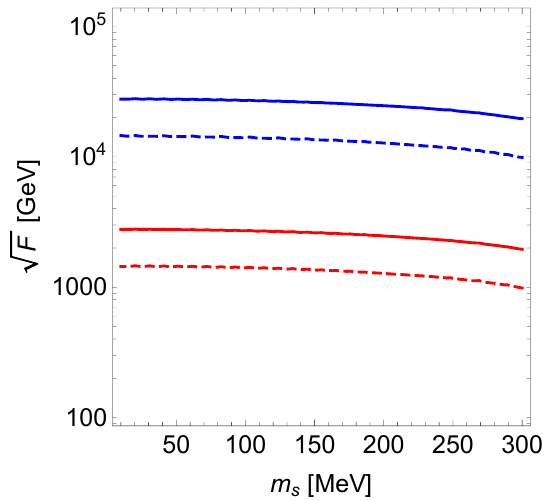
Figure 1 . Contours for branching ratios of processes K L ! (cid:25) 0 s and K + ! (cid:25) + s . The solid colored lines indicate the contours for BR( K L ! (cid:25) 0 s ). Dotted lines of corresponding colors show where BR( K + ! (cid:25) + s ) achieves the corresponding value: blue for BR = 10 (cid:0) 8 , red for BR = 10 (cid:0) 6 . We set p A 0 = 0 : 2 F